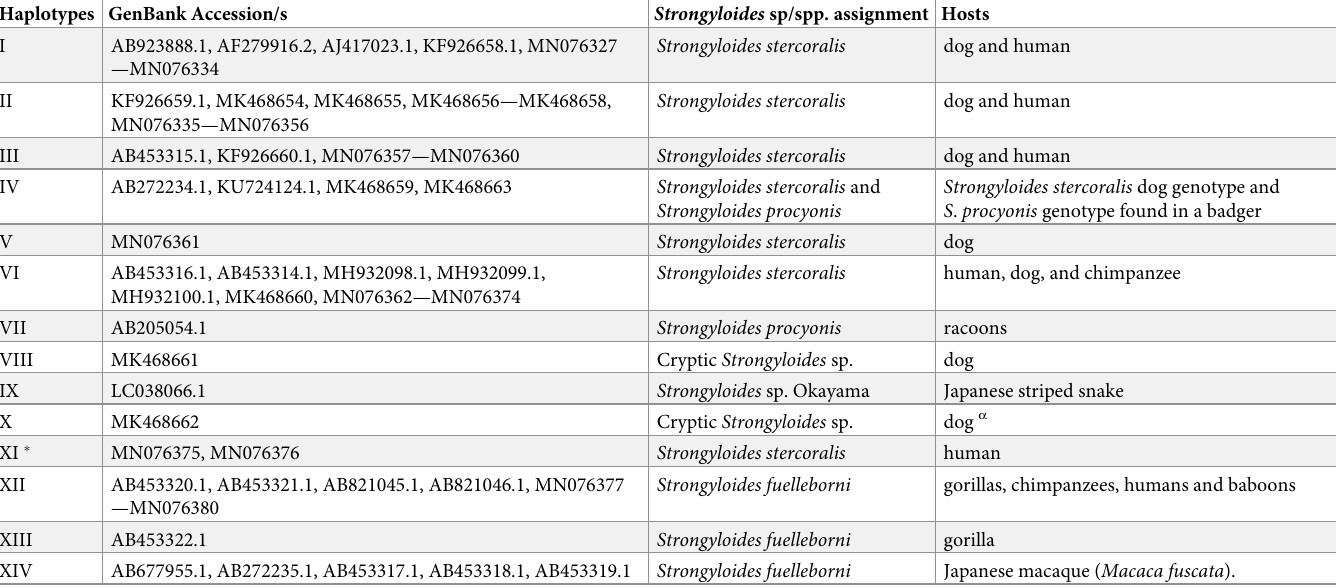
Table 2. HVR-I haplotypes assigned to Strongyloides spp. as part of this typing